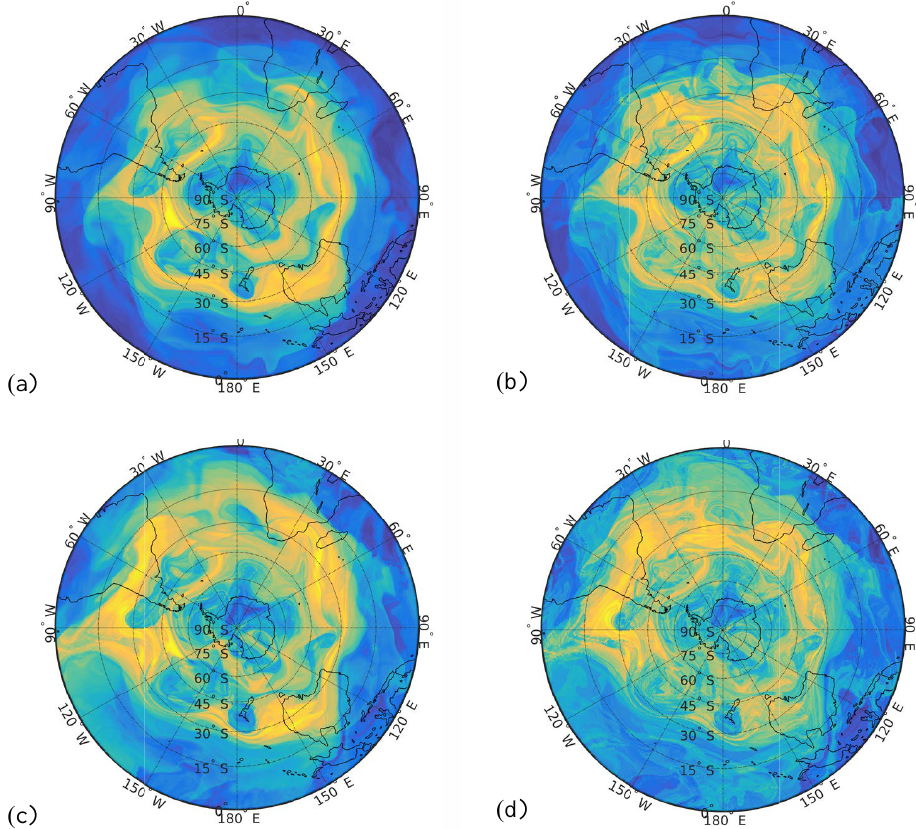
Figure 3. M calculated on 15 August 1979 at 00:00:00UTC: (a) using a 2-D approach where particle trajectories are constrained to the 330K potential temperature level and τ = 5 days; (b) the same with τ = 10 days; (c) M calculated for τ = 5 days using a 3-D computation of trajectories and represented at a constant height level of h = 10km (which corresponds approximately to the 330K isentropic surface); (d) the same with τ = 10